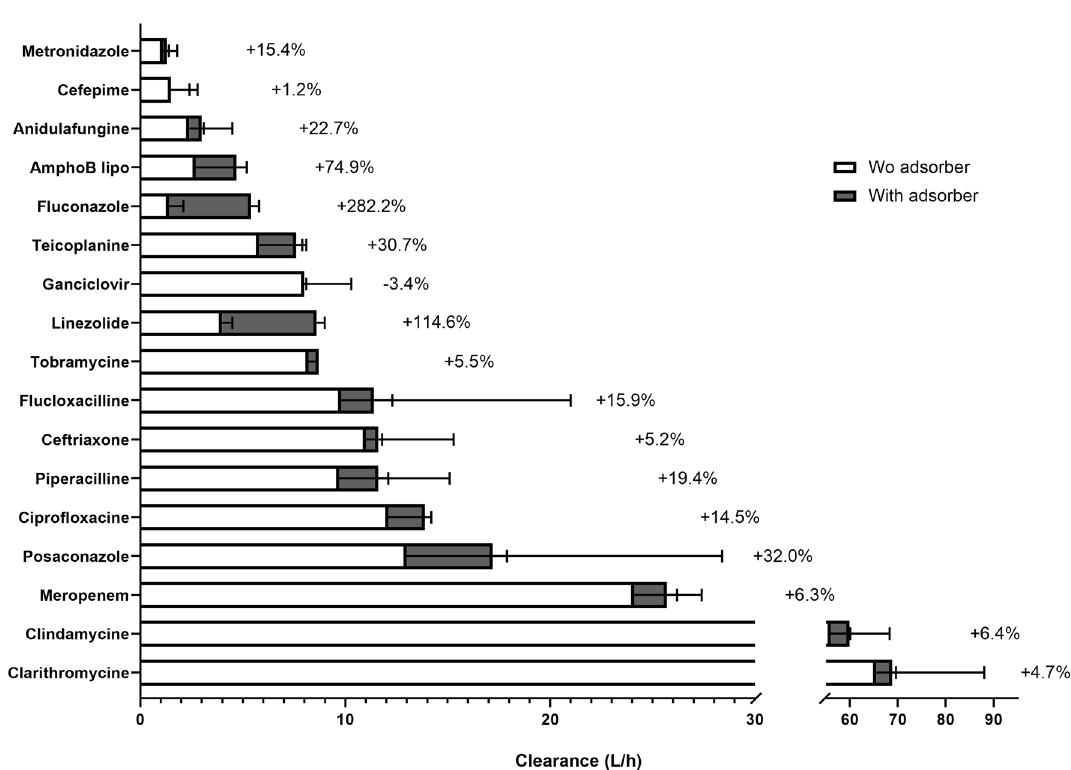
Figure 3. Additional clearance provided by adsorber. The white areas of the bars represent endogenous drug clearance (without adsorber) while the grey areas represent the additional clearance provided by the adsorber under the experimental conditions. Percentage refer to the relative increase in clearance associated with adsorber insertion. AmphoB lipo: liposomal amphotericin